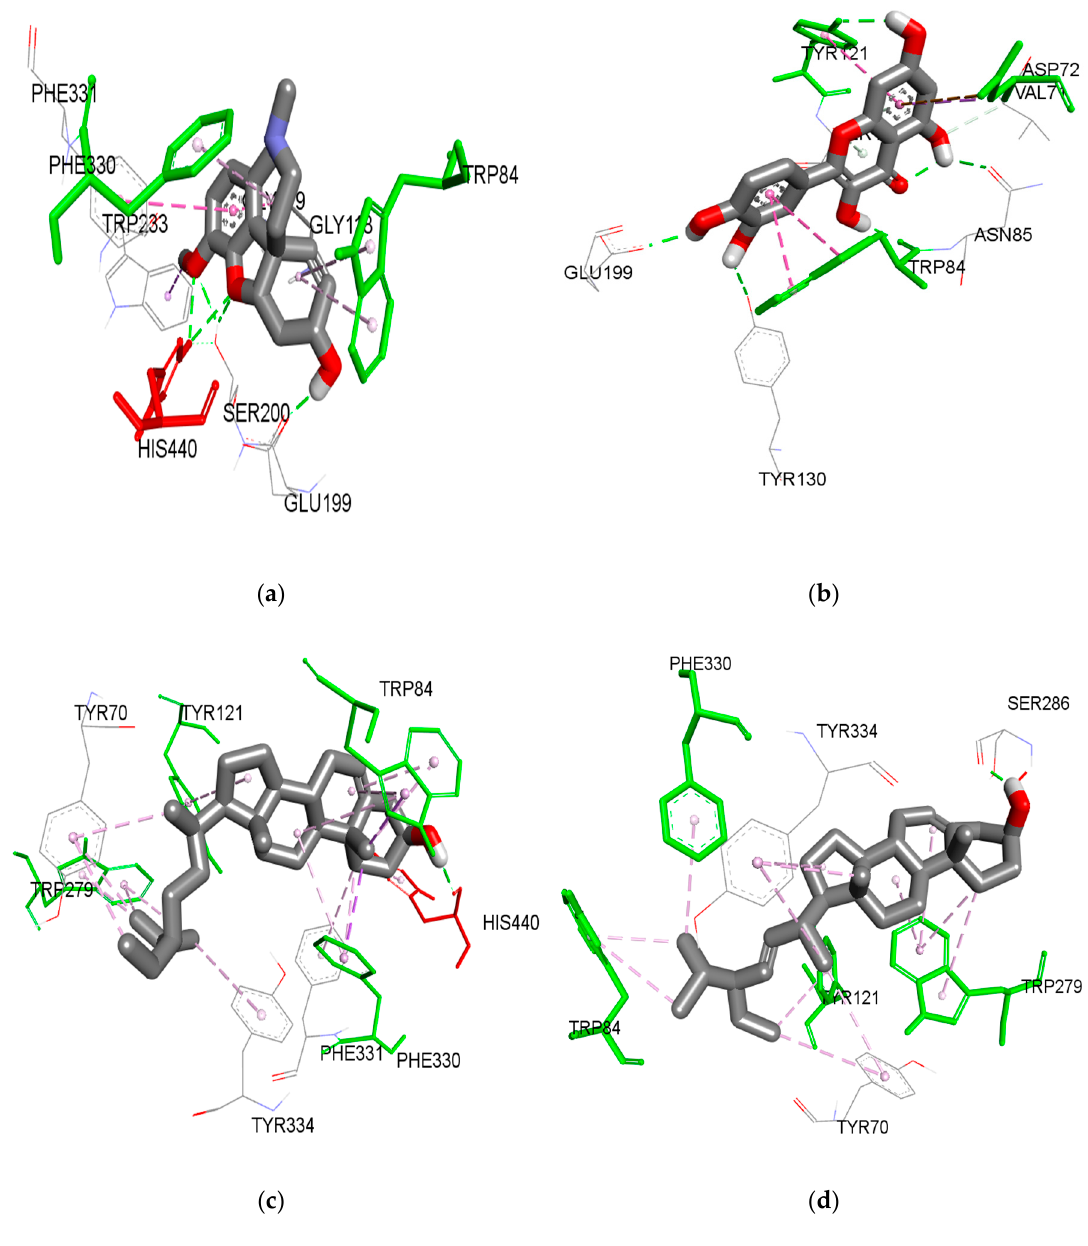
Figure 3. Interactions of compound ( a ) galanthamine, ( b ) 3-methoxy quercetin, ( c ) β -sitosterol, and ( d ) stigmasterol with PAS (amino acid in green) and the acyl pocket (amino acid in red) in the active site of TcAChE. The dotted green line is the hydrogen bond, purple is the Pi-sigma bond, and pink is the Pi-alkyl bond interaction.